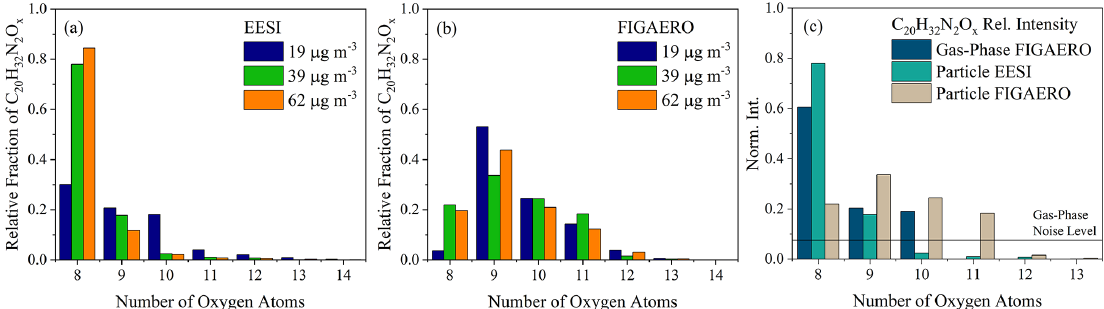
Figure 3. The oxygen atom distribution for C 20 H 32 N 2 O 8 − 14 molecules observed by (a) the EESI-ToF and (b) the FIGAERO-CIMS for Exp. 1 (blue), 2 (green), and 3 (orange), respectively, normalized to the total C 20 H 32 N 2 O x signal. The EESI-ToF data are averaged over the first 10min of the experiments, whereas the FIGAERO-CIMS data represent the first filter desorption. (c) The oxygen atom distribution for the FIGAERO-CIMS (gas phase) averaged over the first ∼ 5 min from Exp. 2. The solid line denotes the limit of detection for the